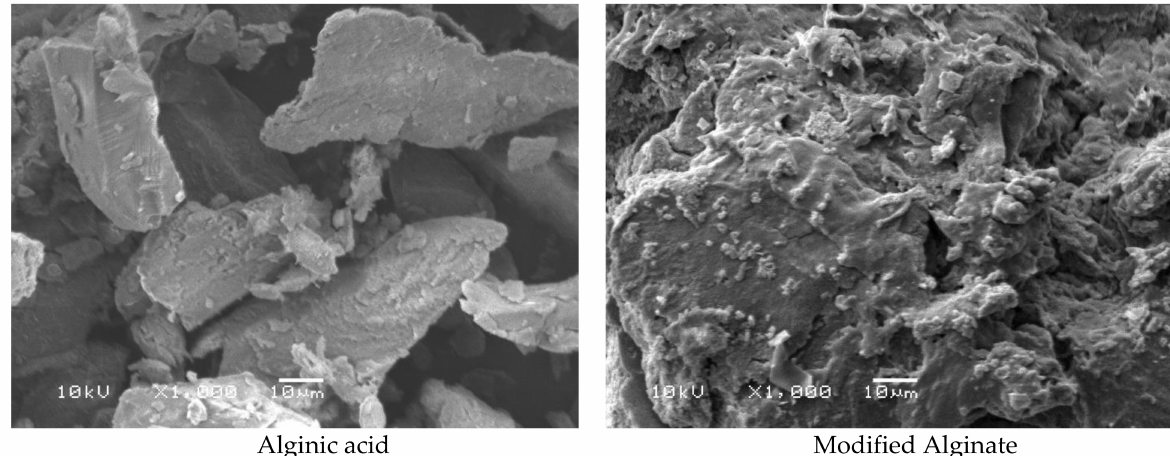
Figure 5. SEM images of alginic acid and its aromatic